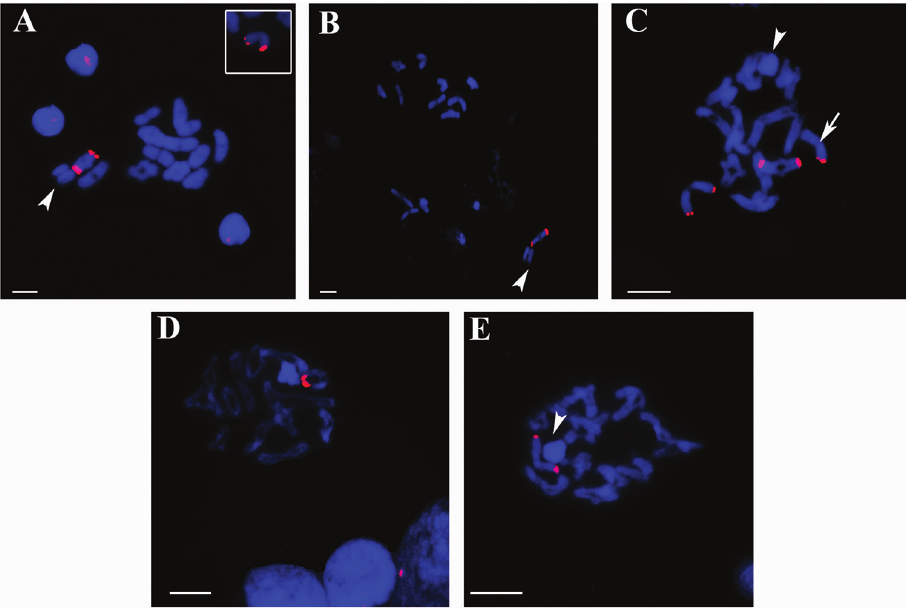
Figure 3. Ctenidae male meiotic cells, FISH with rDNA 18S probe. Arrowhead - sex chromosomes. A diakinesis of Ctenus ornatus : in the box the bivalent with size heteromorphism of 18S rDNA sites B di- akinesis of Ctenus medius C diakinesis of Phoneutria nigriventer : arrow - bivalent with 18S rDNA sites in only one of the chromosomes D diplotene of Viracucha andicola E diplotene of Enoploctenus cyclothorax . Bar = 10 µm.